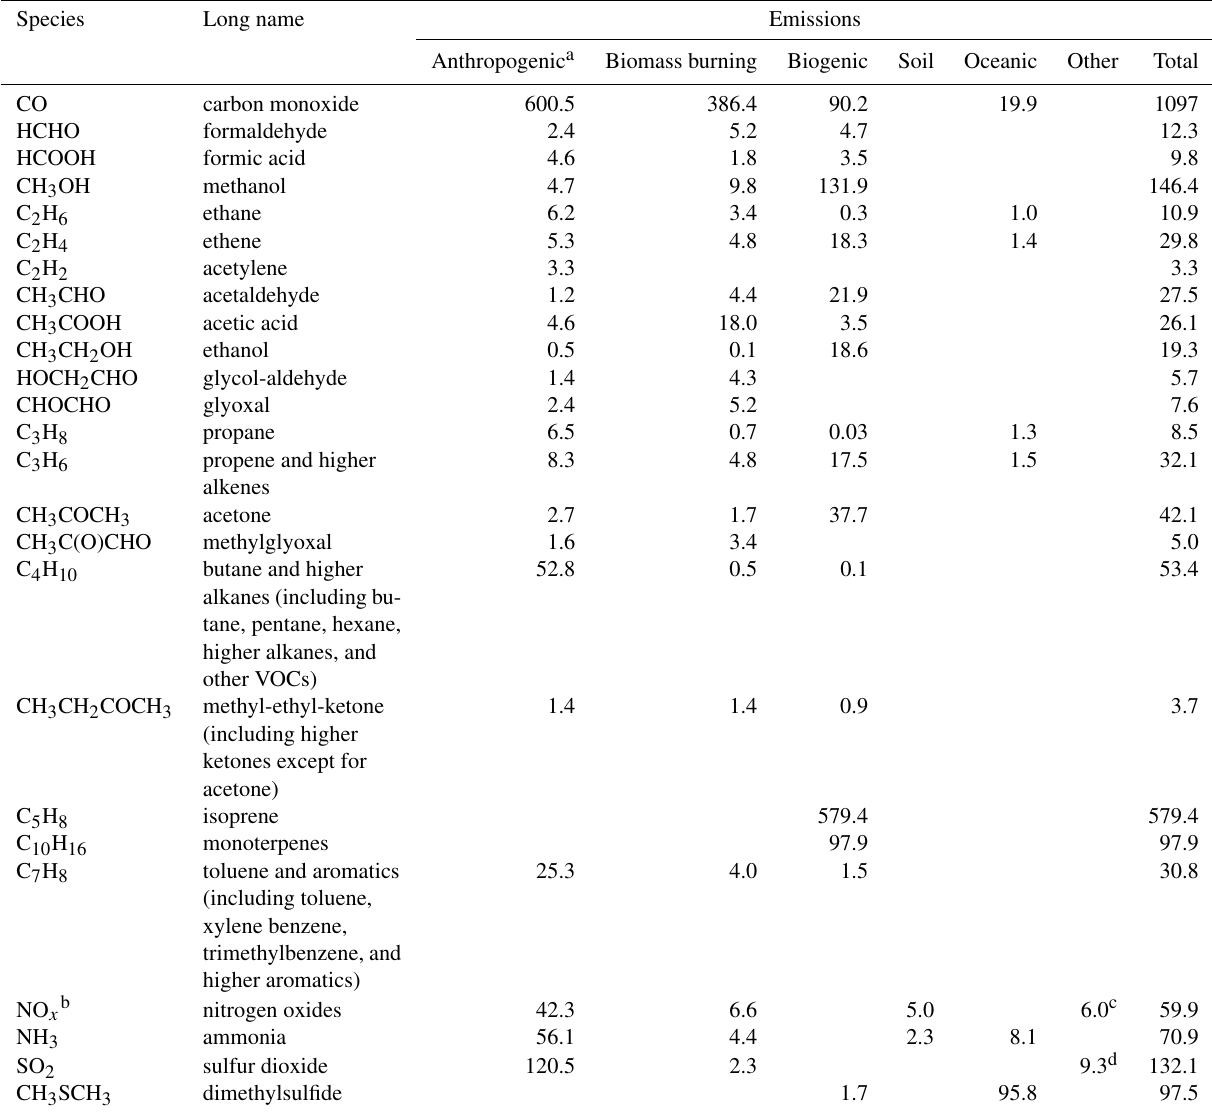
Table 3. Global annual emissions of trace gases used for the MOGUNTIA chemistry scheme in TM5-MP for the year 2006 (Tgyr − 1 unless specified